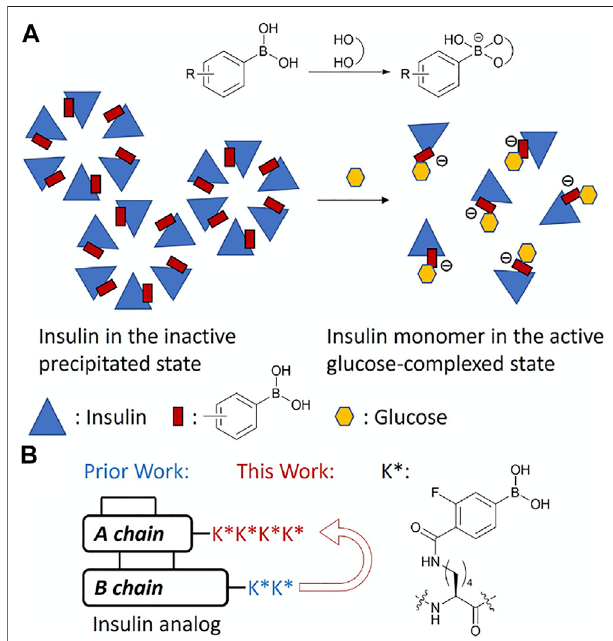
FIGURE1|(A) Schematicmechanismofglucose-responsiveinsulin. (B) Design of FPBA-conjugated glucose-responsive